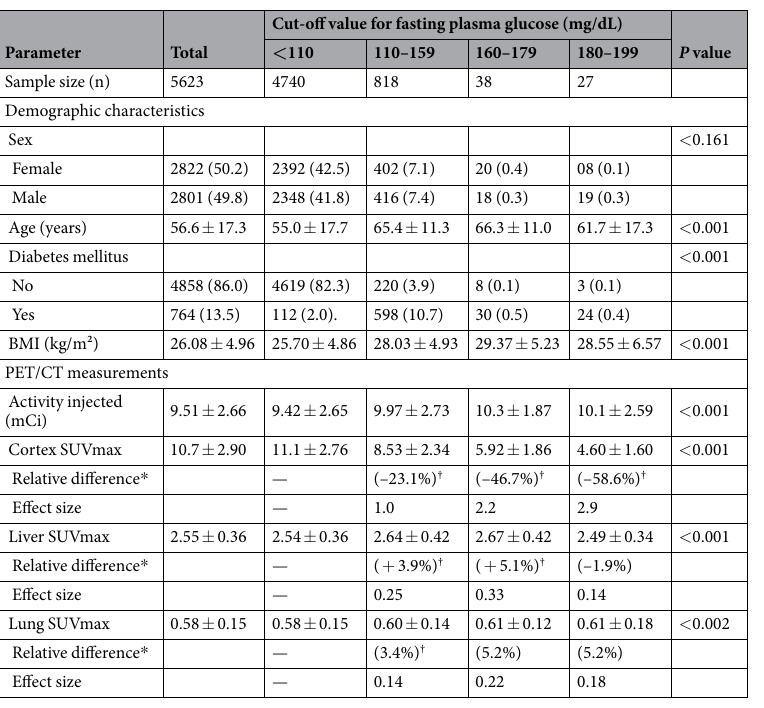
Table 2. Demographic characteristics and PET/CT findings (n = 5623). Data are expressed as mean ± standard deviation or n (%), unless otherwise noted. BMI = body mass index; PET/CT = positron emission tomography/ computed tomography; SUVmax = maximum standardized uptake value. * Calculated as the ratio of the mean SUVmax in each category divided by the mean SUVmax in the glucose < 110 mg/dL group. † p < 0.05 in the post-hoc analysis, with glucose < 110 mg/dL serving as the control